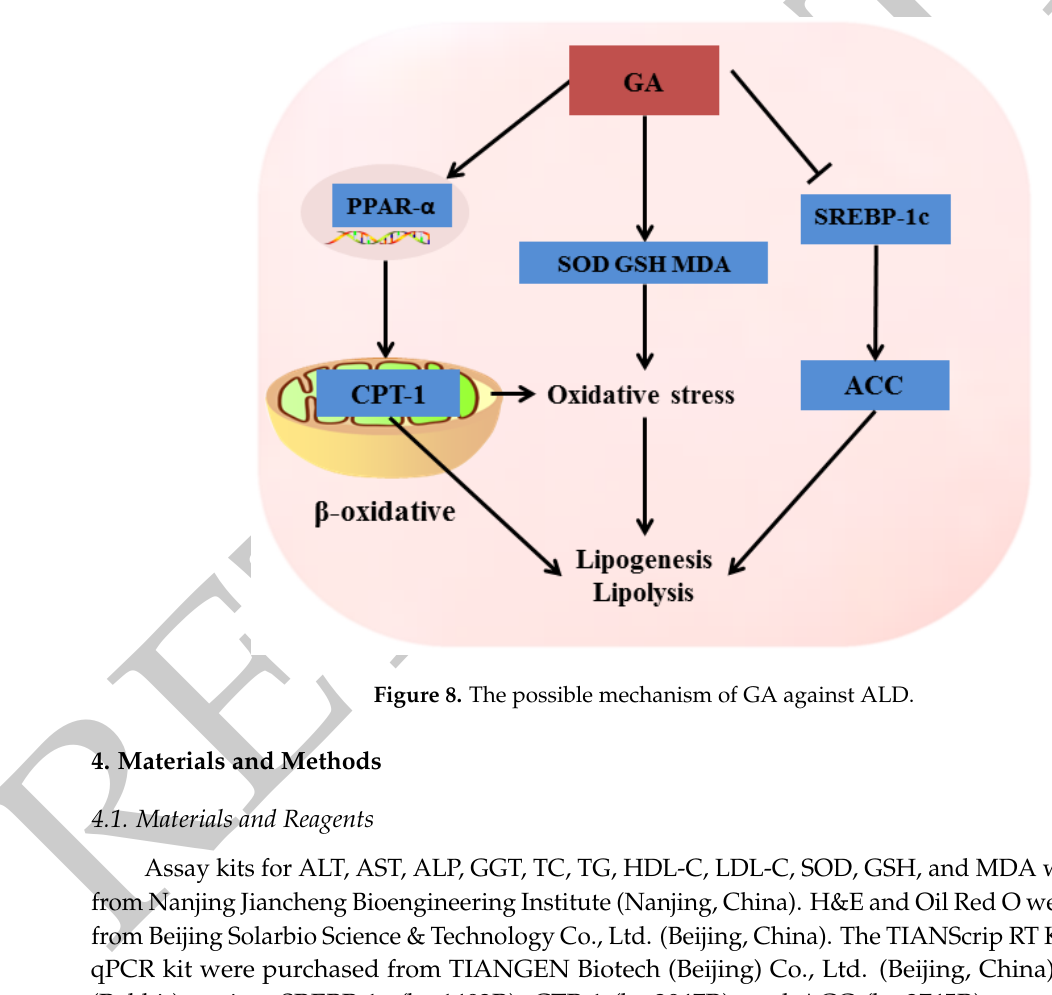
Figure 8. The possible mechanism of GA against ALD.